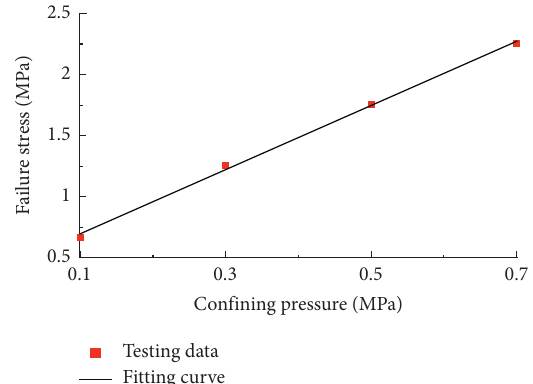
Figure 19: Failure stress of stabilized soils with different confining pressure (stabilizer content � 5%; curing time � 3 days).